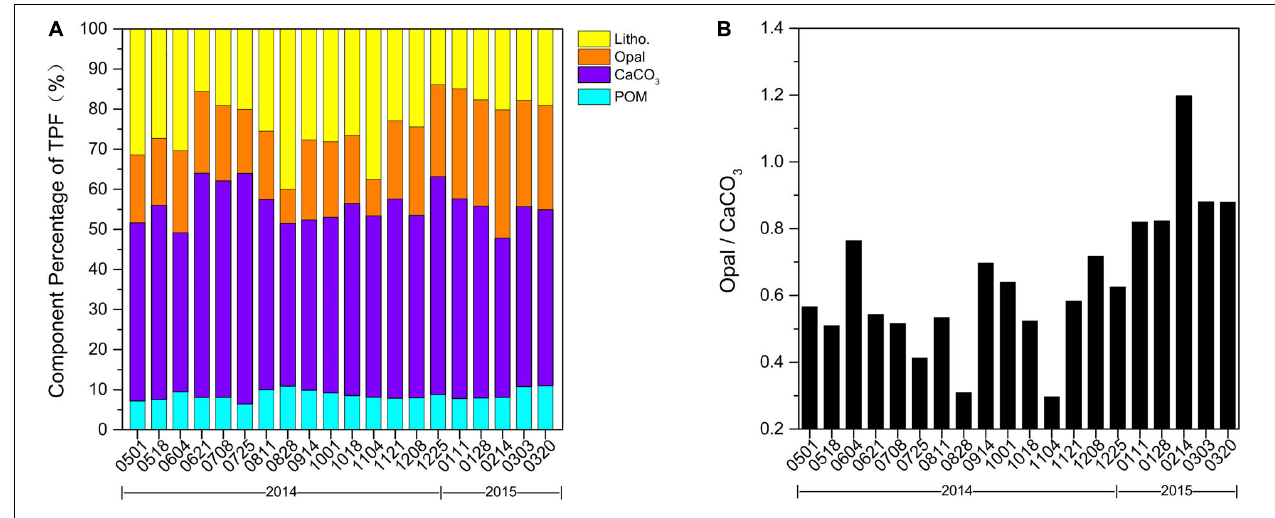
FIGURE 3 | (A) Component percentage of total particle fluxes (TPF) and (B) mole ratio of opal/CaCO 3 in sinking particulate fluxes at station SCS-N, May 01, 2014 to April 06, 2015. POM symbolizes particulate organic matter.